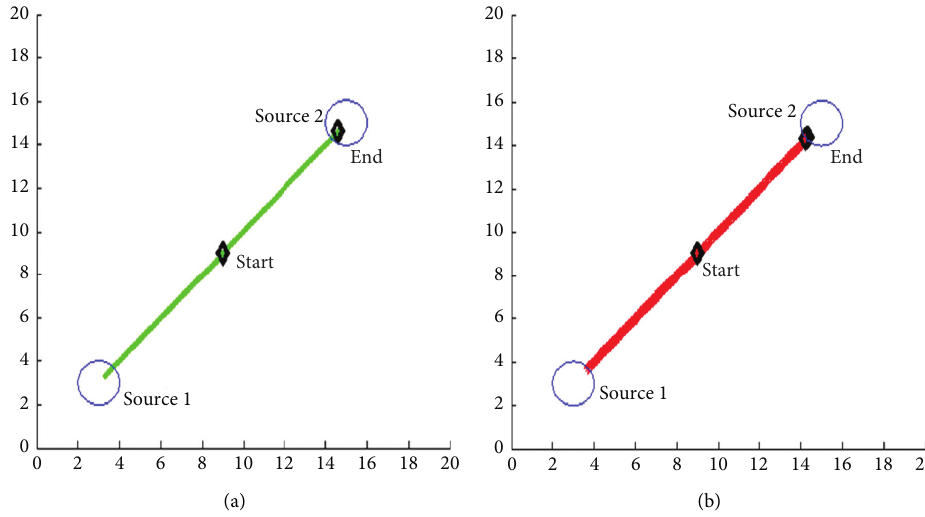
Figure 10: The trajectories for PD and PDS with escape strategy. (a) The trajectory for PS with escape strategy. (b) The trajectory for PDS with escape strategy.